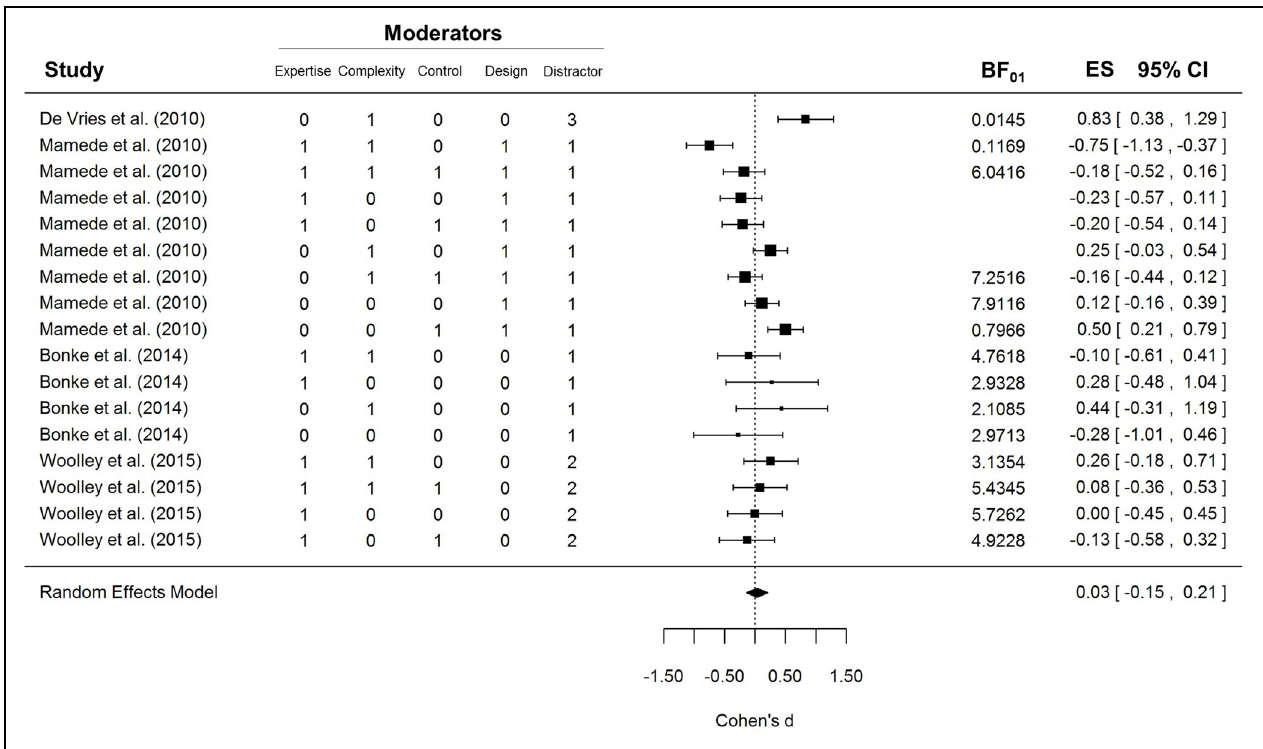
(0) or an immediate condition (1); Design, i.e., whether the study design was between- (0) or within-participants (1); and Distractor, i.e., whether the distraction task in the UT condition was anagrams (1), an n -back task (2), or a word-search puzzle (3).